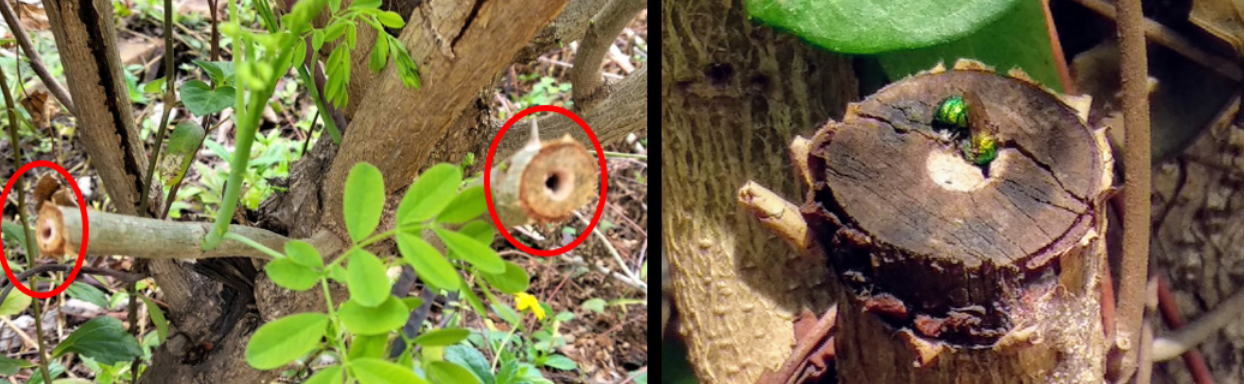
Fig 1. Pruned cut ends of Caesalpinia pulcherrima with Ceratina binghami showing nest building